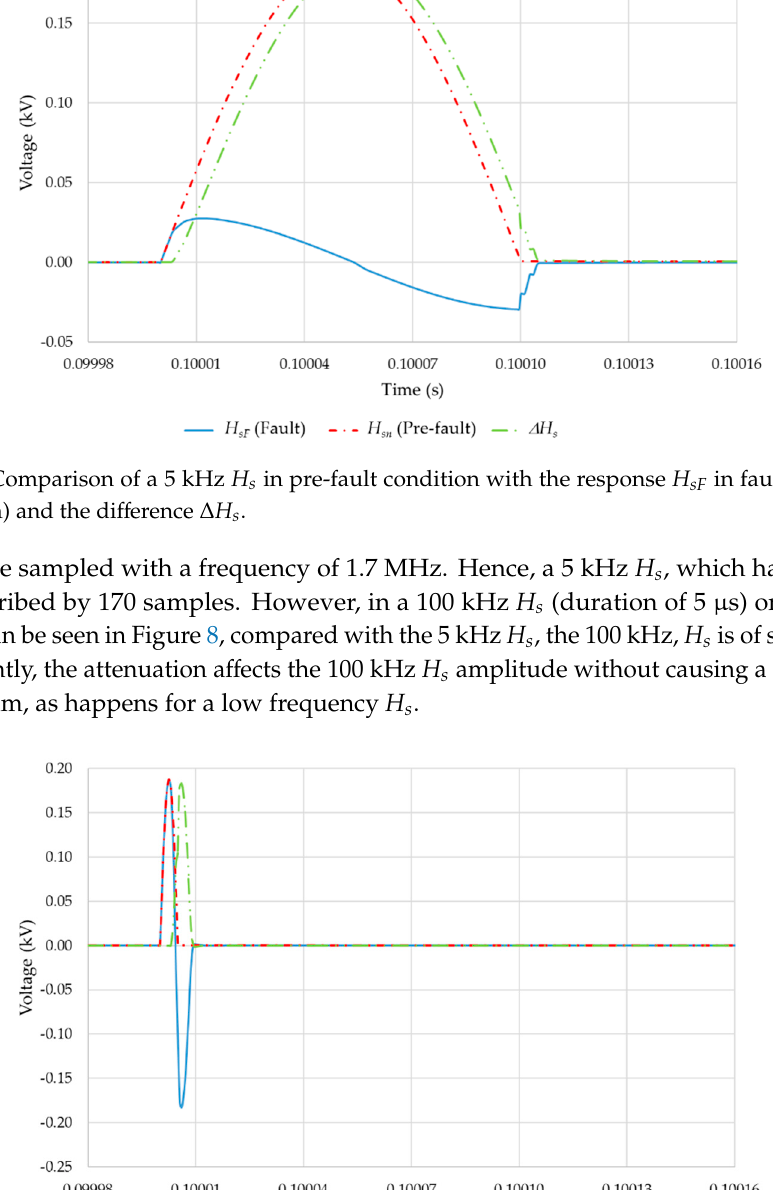
Figure 8. Comparison of a 100 kHz H s in pre-fault condition with the response H sF in fault condition (d = 0.5 km) and the di ff erence ∆ H s .